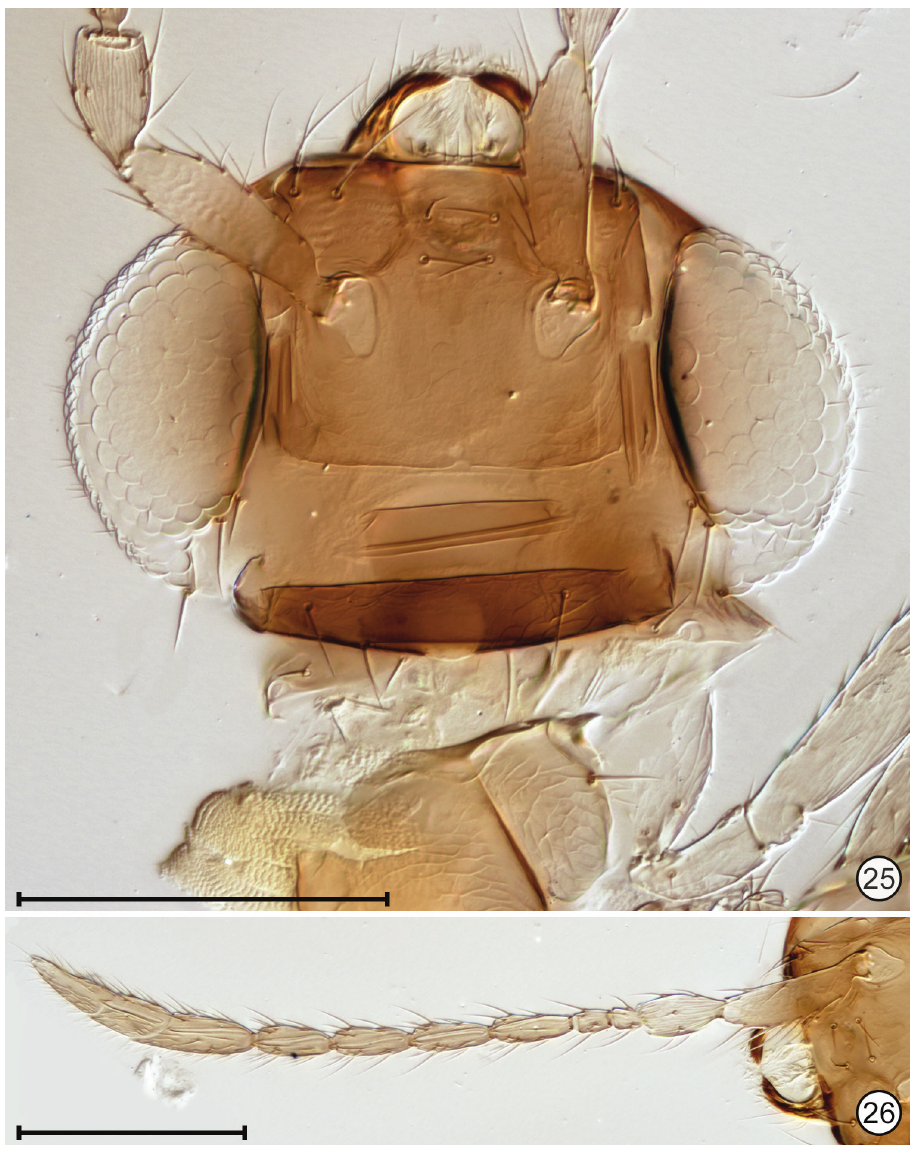
Figures 25, 26. Paranaphoidea occidentalis holotype 25 head, anterior + crushed pronotum 26 antenna. Scale bars: 100